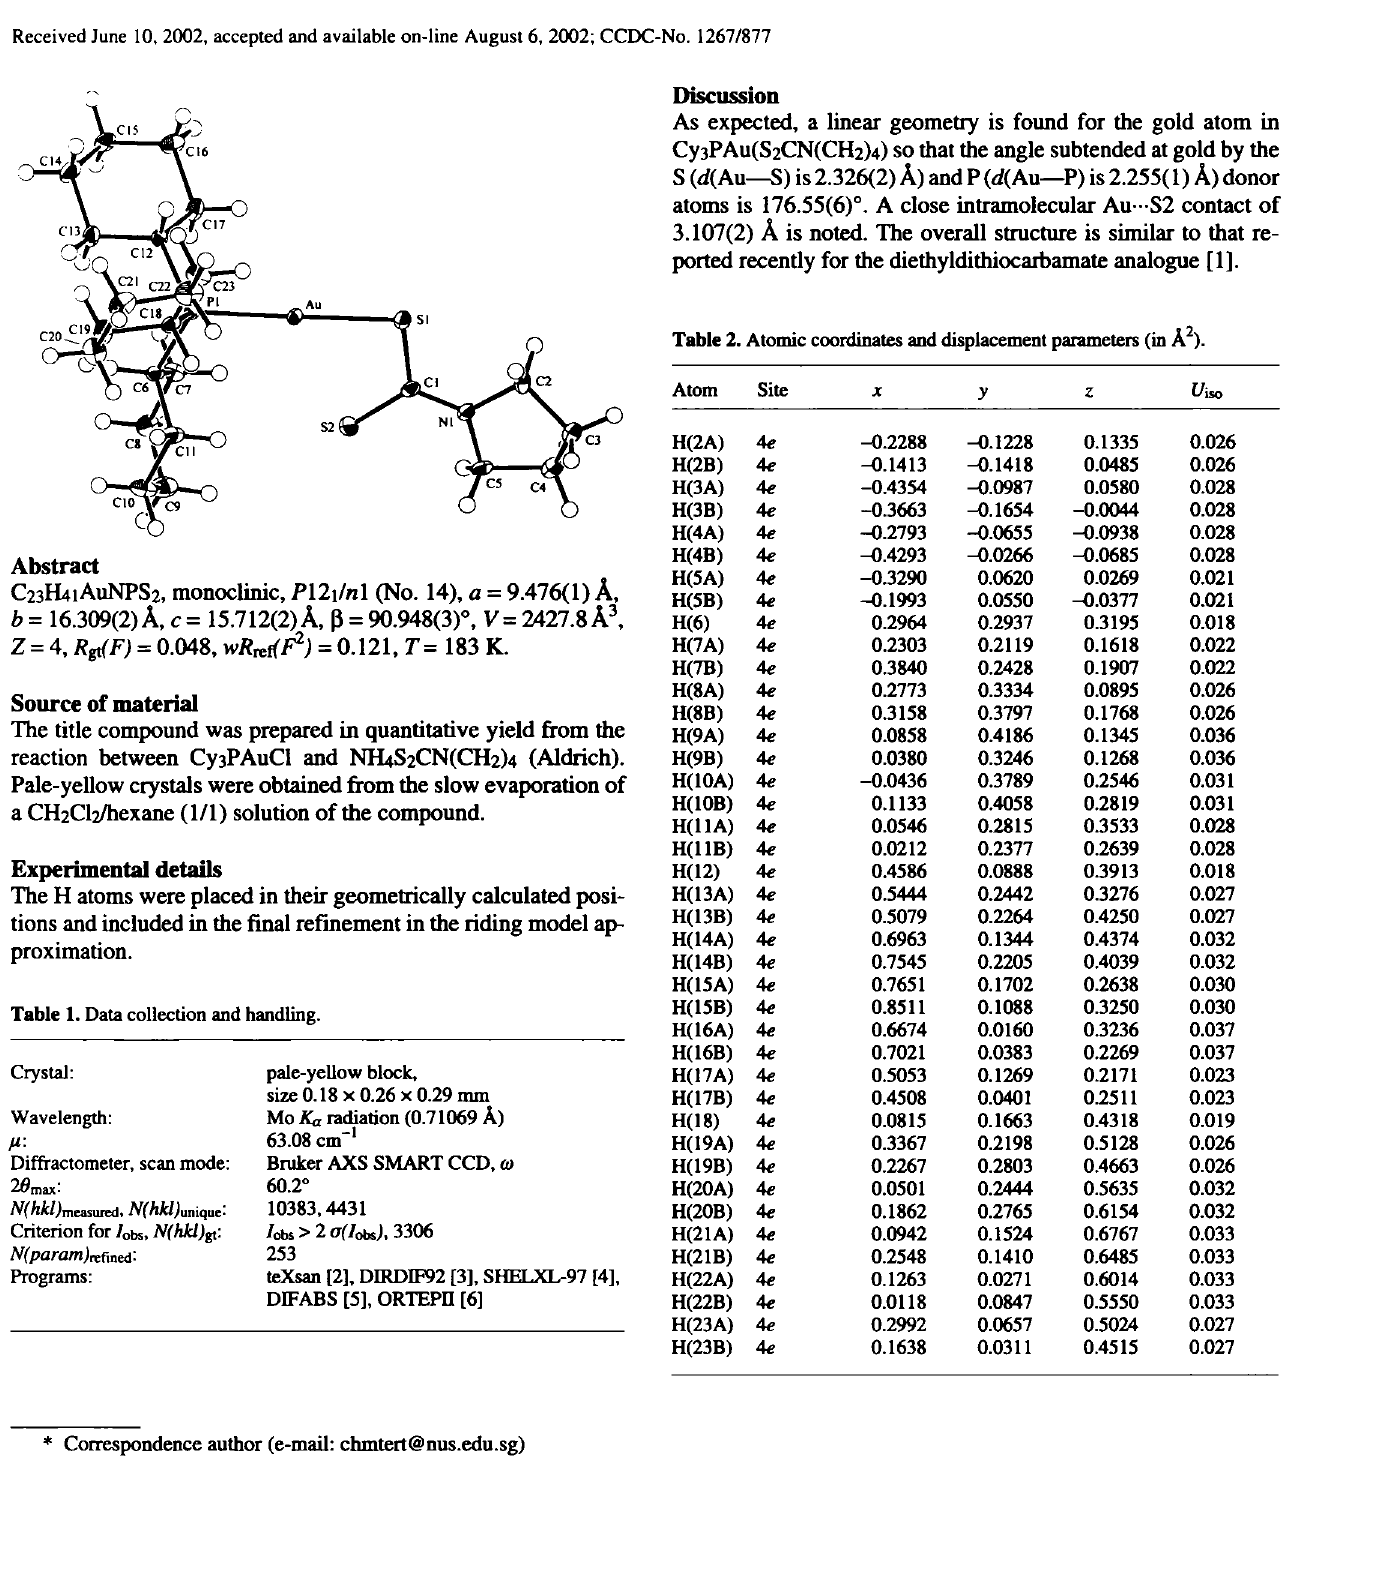
Table 2. Atomic coordinates and displacement parameters (in À 2